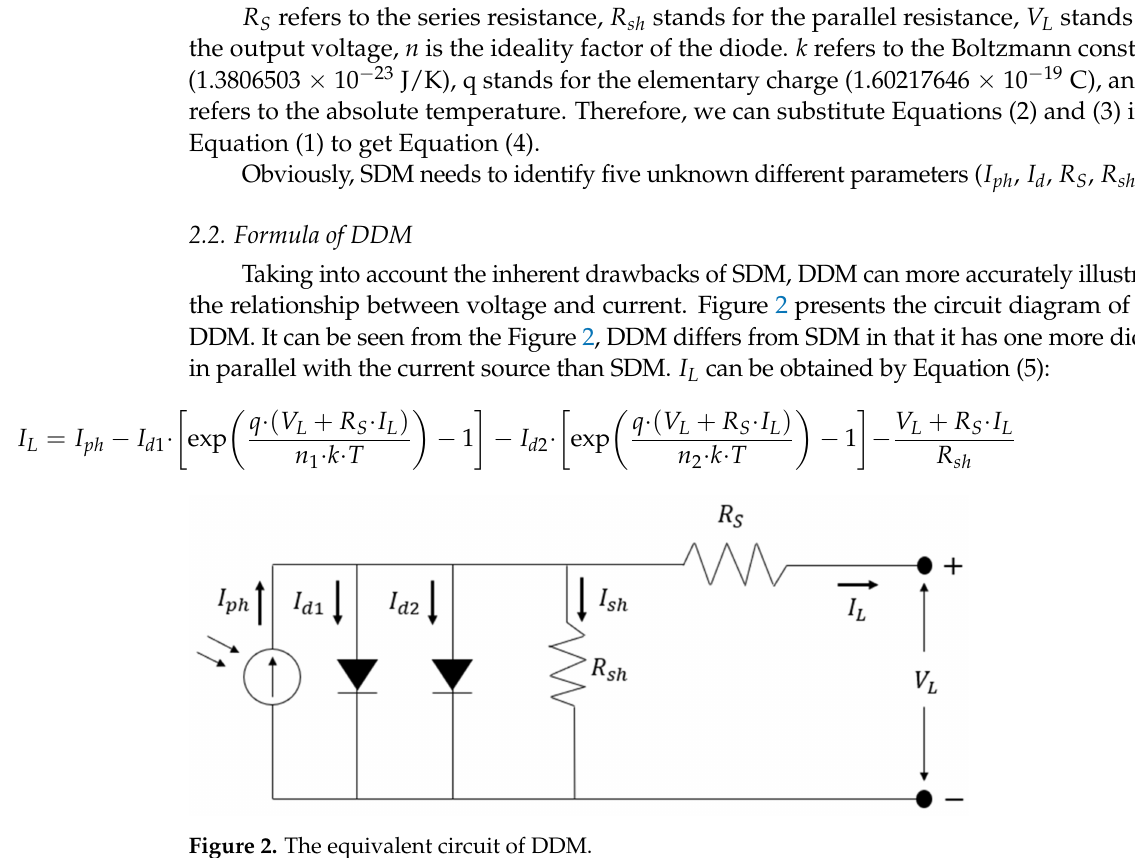
Figure 2. The equivalent circuit of